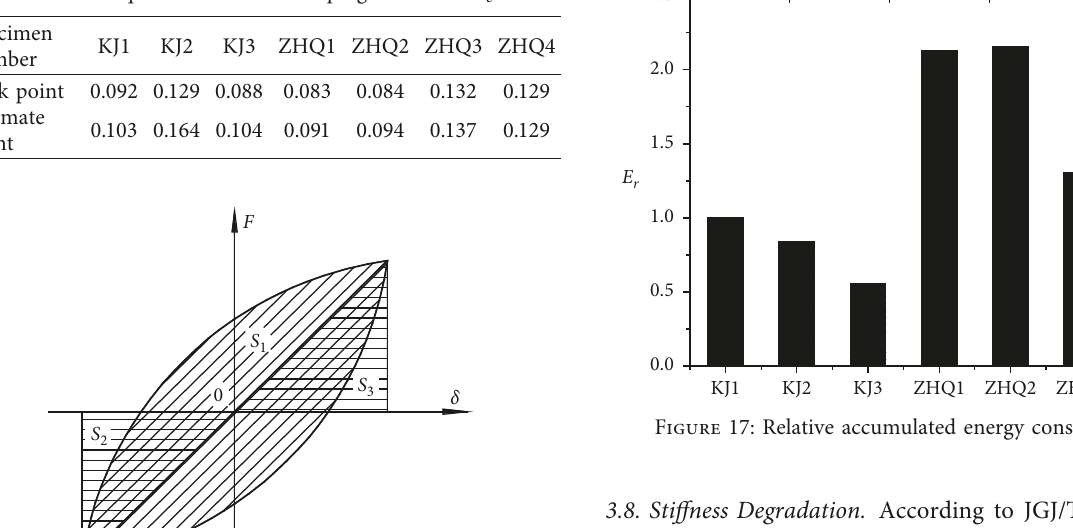
Figure 15: Bearing capacity degradation. (a) Concrete gird frame wall. (b) Cast-in-place phosphogypsum-reinforced concrete grid frame composite wall. Table 6: Equivalent viscous damping coefficient h e .